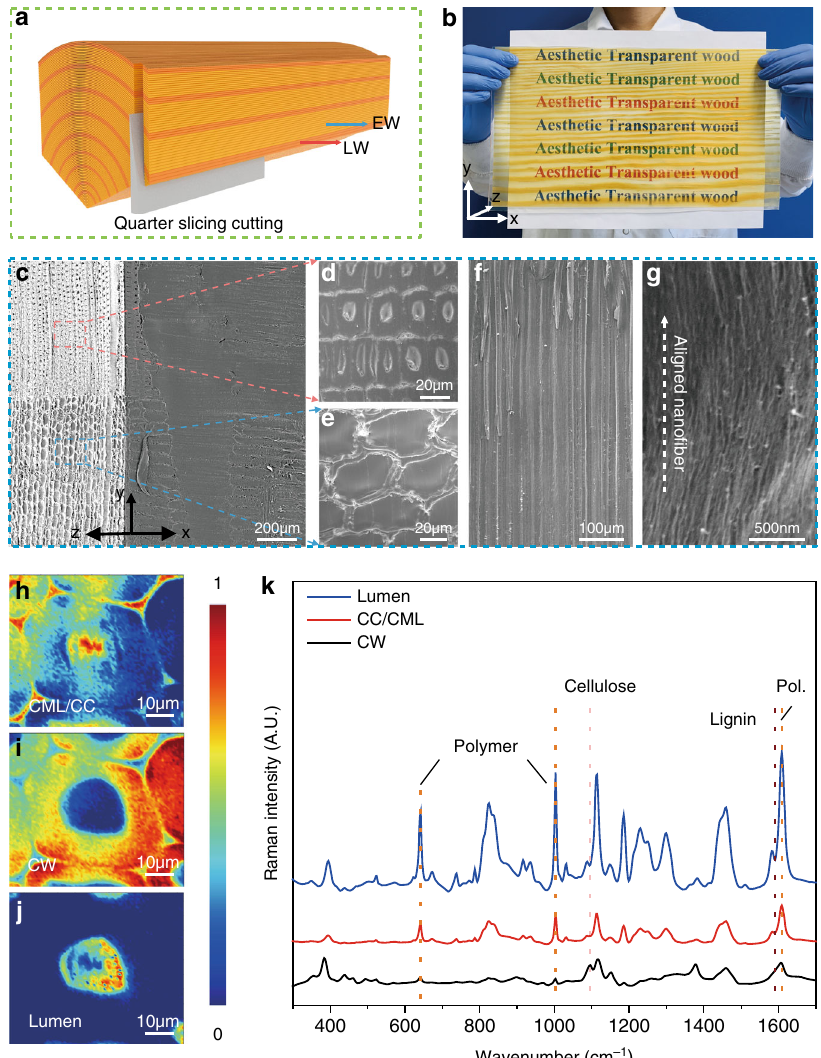
Fig. 3 Scalability of aesthetic wood. a Schematic of quarter slicing cutting to obtain the wood veneer with straight-line patterns. b A large-scale aesthetic wood assembled by L-wood veneer (demonstrated for sample size of 320 mm × 170 mm × 0.6 mm). c SEM image of the preserved whole wood microstructure after fi lling with polymer. d – e Zoomed-in SEM images to show the EW and LW well-de fi ned lumina full of polymer. f – g The detailed SEM image of the aligned micro-sized channels and the aligned cellulose nano fi bers on the corresponding cell wall. h – j VCA of wood cells in obtained aesthetic wood. k Corresponding